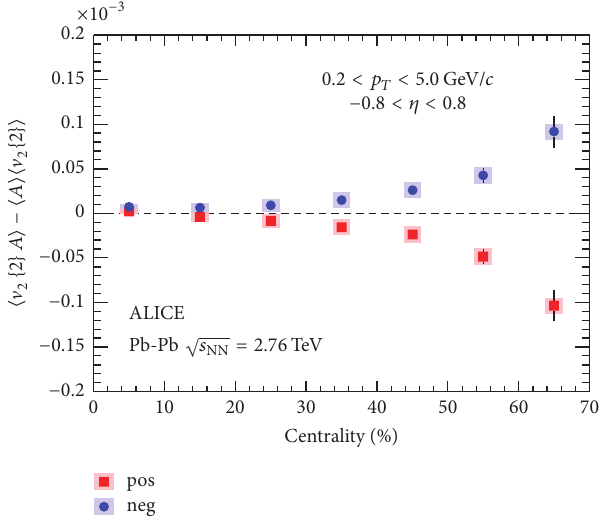
Figure 17: Three-particle correlator for the second harmonic, for positive (red squares) and negative (blue circles) particles for 2.76 TeV Pb+Pb [82]. Statistical (systematic) uncertainties are indicated by vertical bars (shaded